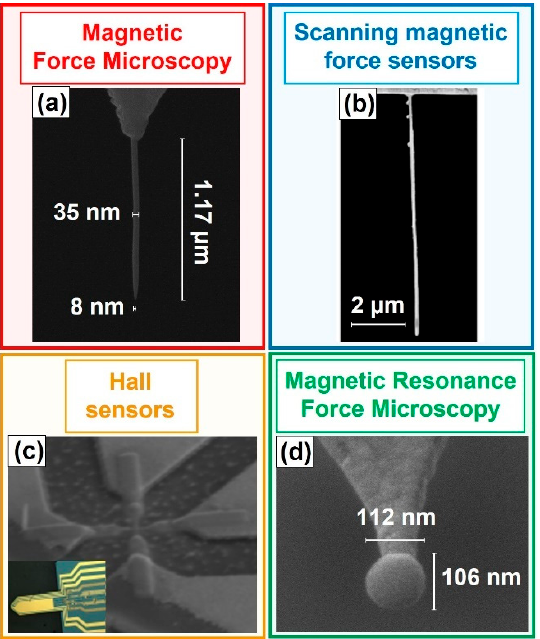
Figure 12. SEM micrographs of the four types of sensors discussed: ( a ) Magnetic Force Microscopy; ( b ) Scanning nanowire magnetic force sensors, ( c ) Scanning ferromagnetic Hall sensors and ( d ) Mag- netic Resonance Force Microscopy; reproduced from [43,61,73,77], respectively.